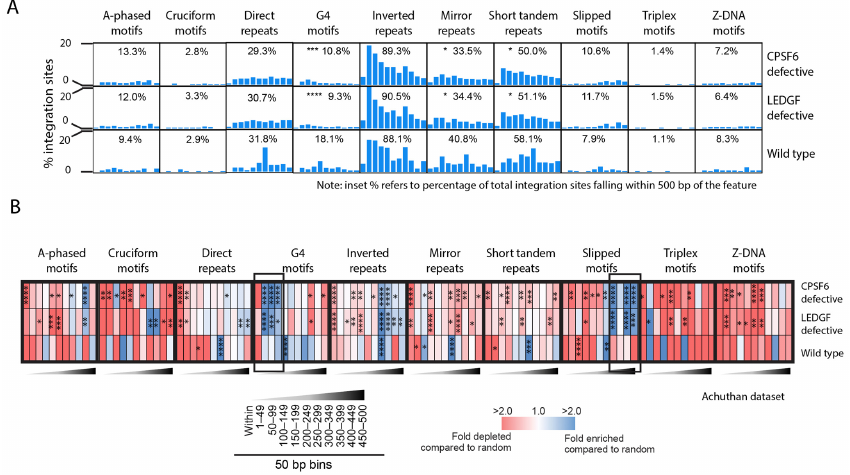
Figure 5. CPSF6 and LEDGF/p75 promote integration near several non-B DNA. ( A ), Graphs show the percentage of total unique HIV-1 integration sites located in or within 500 bp of various non-B DNA motifs (distributed in 50 bp bins) from wild type (control), CPSF6 depleted, or LEDGF/p75 depleted cells. Inset numbers show the percentage of total unique integration sites falling within 500 bp of the non-B DNA motif. Statistical analysis is with respect to wild type. ( B ), Heatmap shows the fold enrichment (blue) or depletion (red) of integration sites at each distance interval from the non-B DNA motif compared to the random control. Black boxes highlight notable regions of